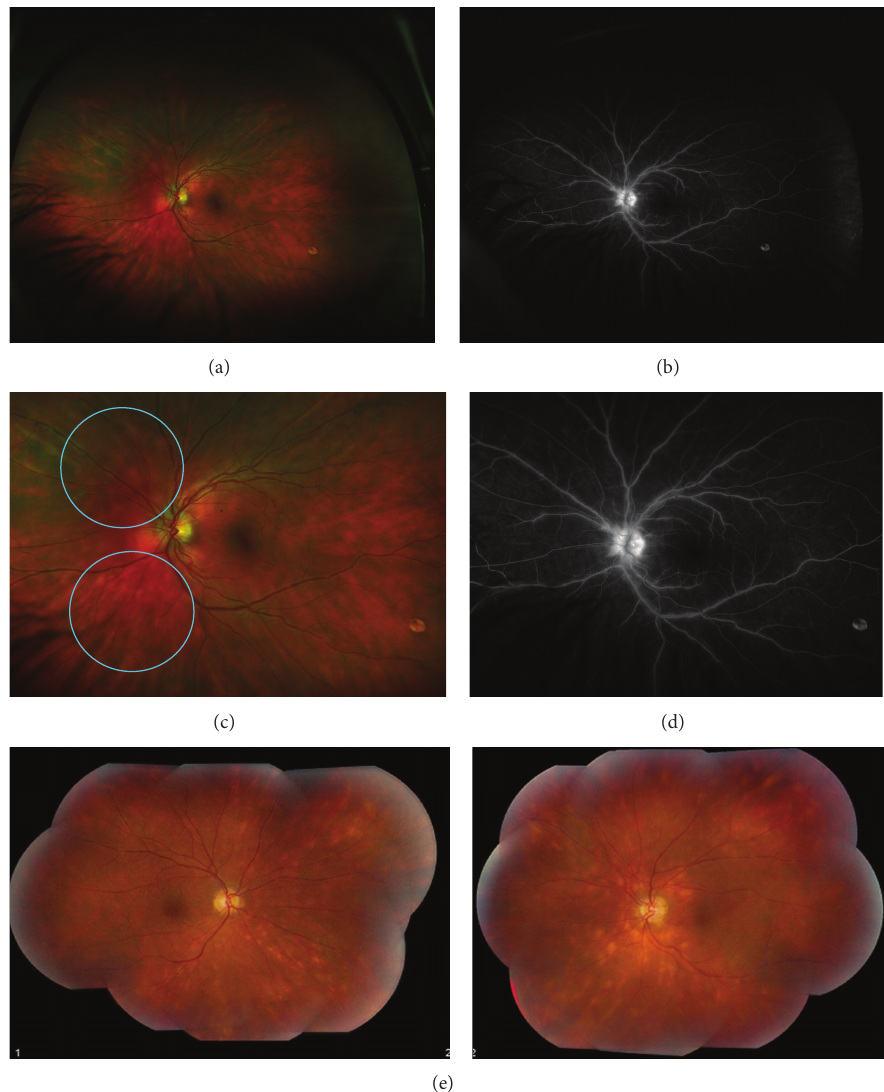
Figure 1: (a) Wide-field fundus photograph of a 34-year-old Caucasian male (diagnosed with BCR one year prior to presentation) with (b) corresponding fluorescein angiogram demonstrating vasculitis. (c) Magnified view of the classic lesions (blue circles) and (d) magnified view of vasculitis and late optic disc leakage. No prior treatment. (e) In contrast, bilateral fundus photography of a 55-year-old Caucasian woman diagnosed with BCR two years prior to presentation with more impressive lesions and vascular sheathing. No prior